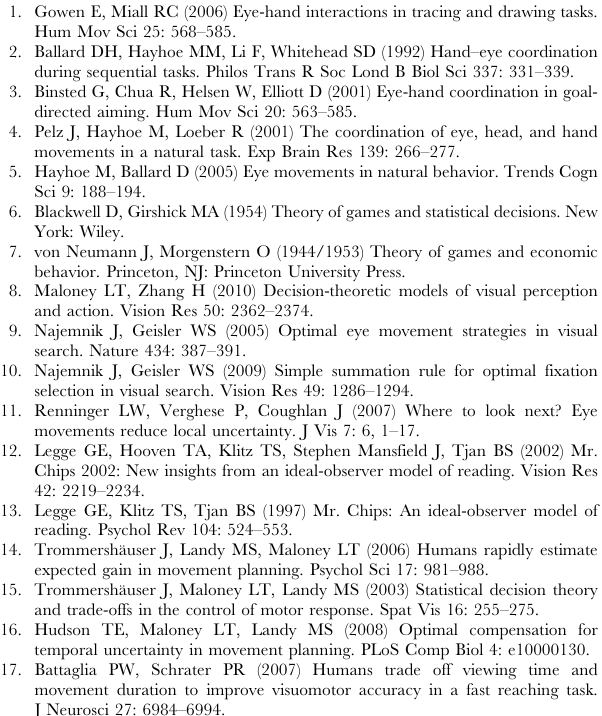
Figure S5 Maximum expected gain as a function of hand movement speed before target was found. (PDF) Video S1 Eye-hand dynamics on one trial.